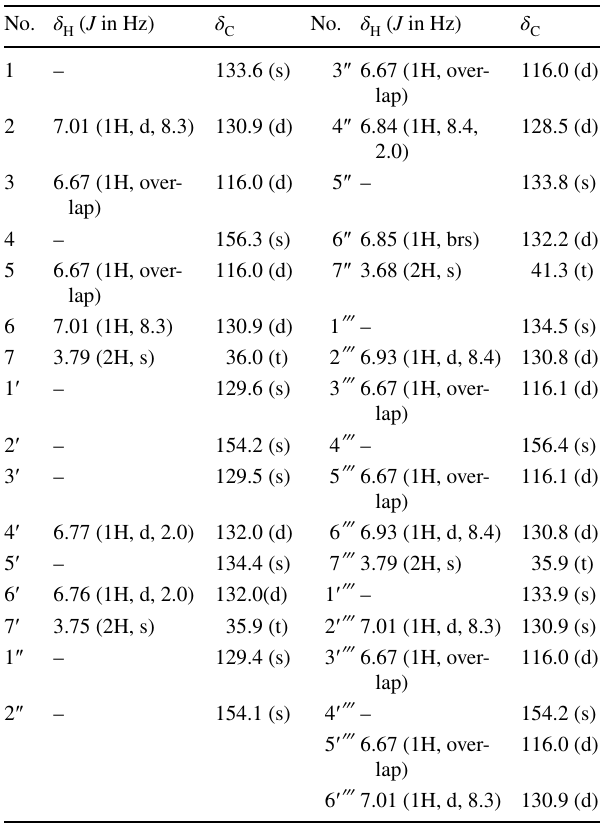
Table 1 1 H-NMR (400 MHz) and 13 C-NMR (100 MHz) data of